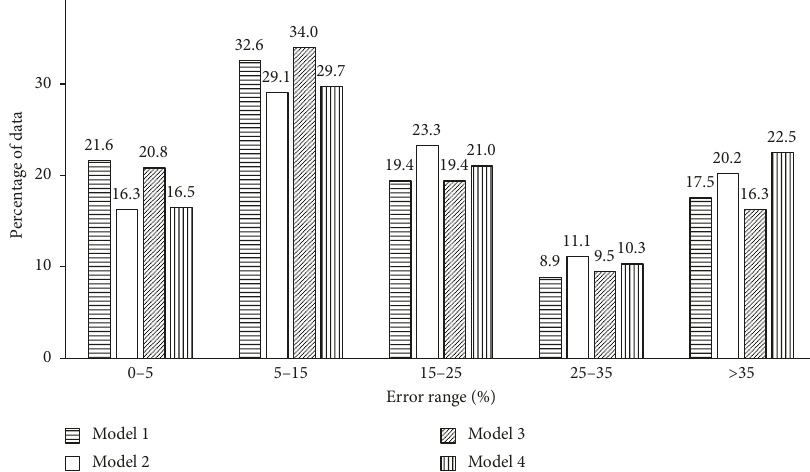
Figure 8: Histogram of error in the prediction of residual strength of concrete by the regression predictive